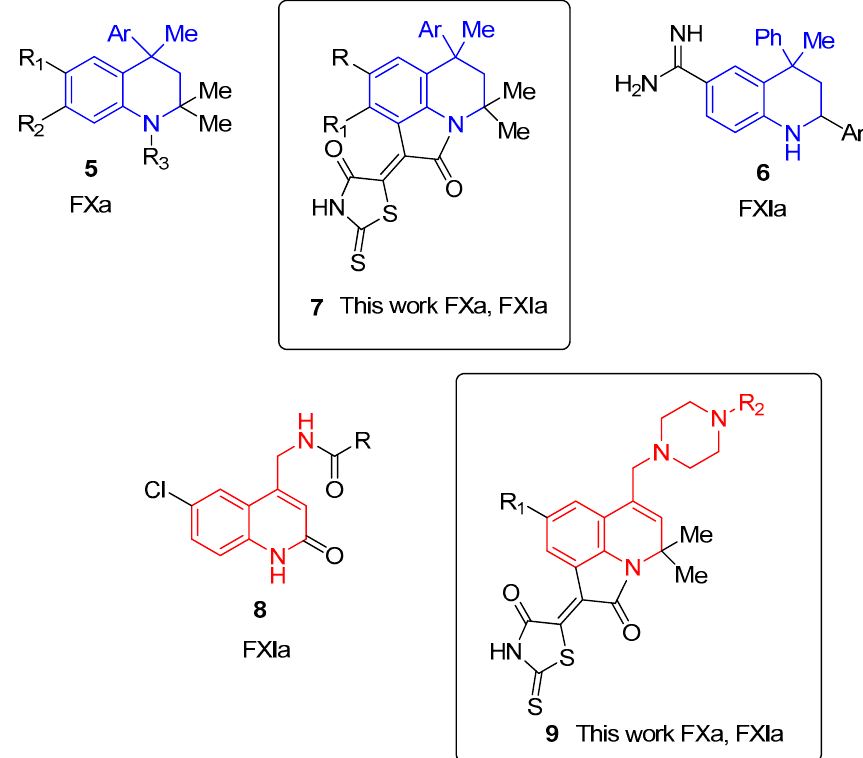
Figure 4. Substituted 1,2,3,4-tetrahydroquinolines ( 5,6 ) , N-acetylaminomethyl-1,2-dihydroquinoline ( 8 ), and hybrid moieties studied in this work as the basis for FXa and FXIa inhibitors ( 7 and 9 –shown in boxes).